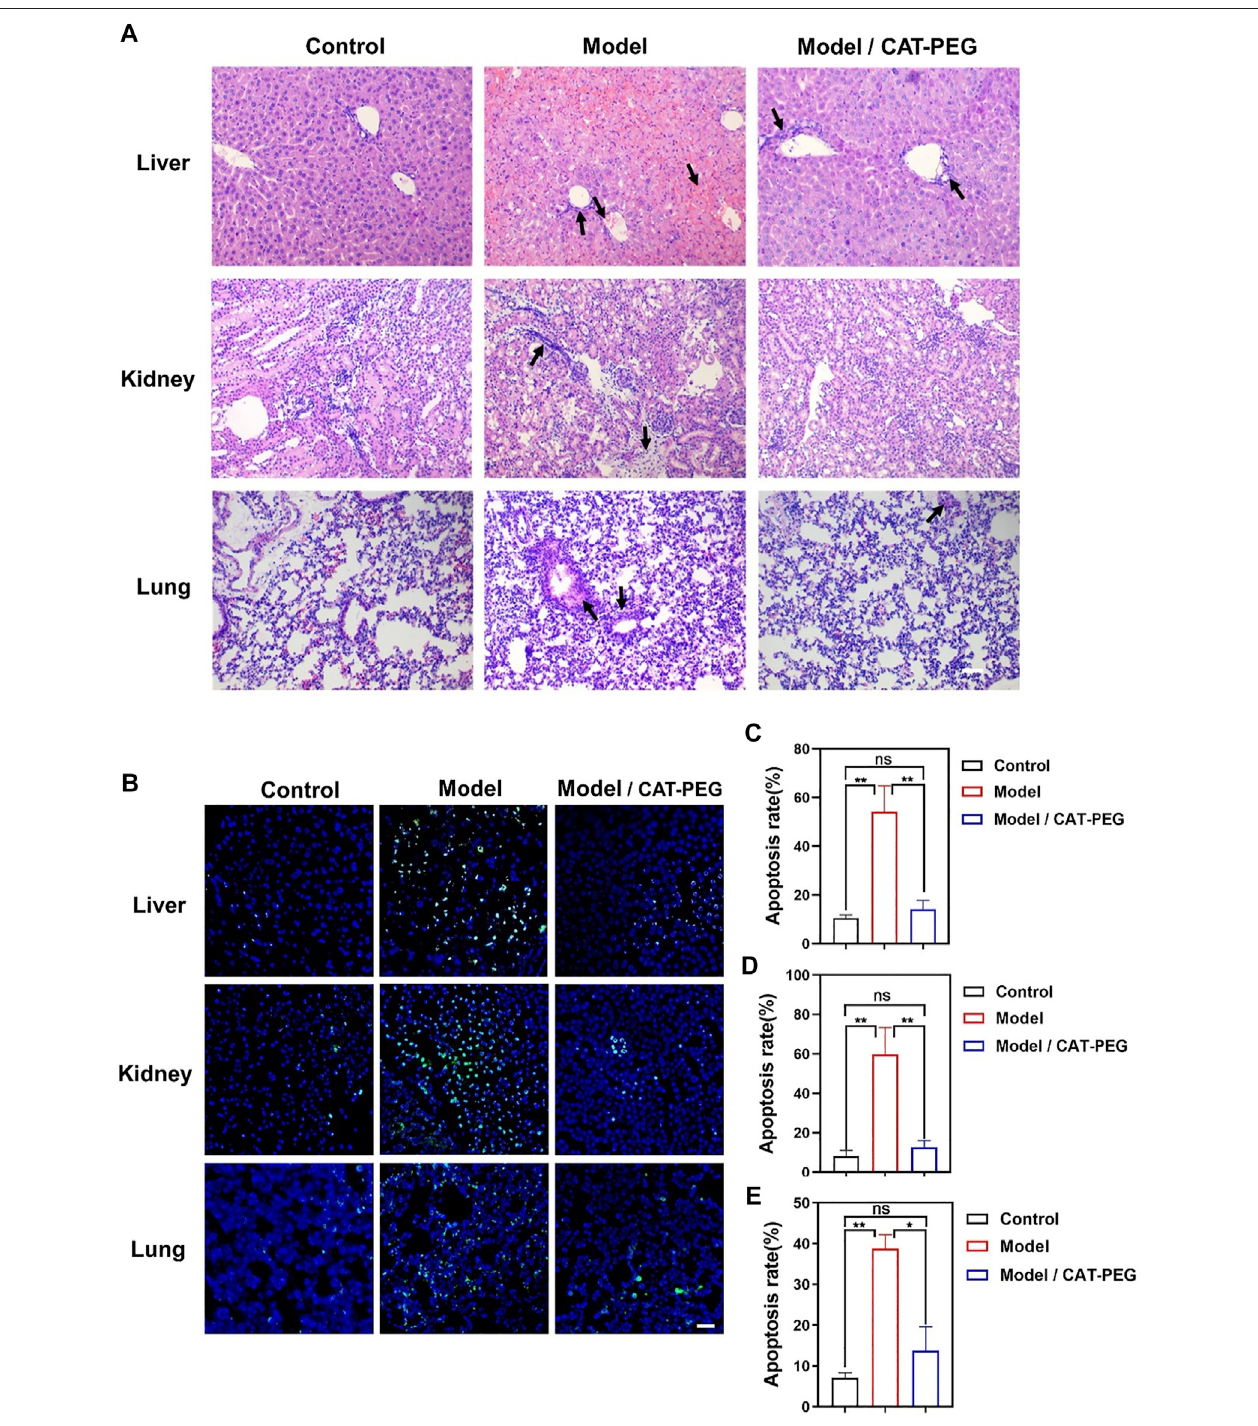
FIGURE5| Histologicanalysisofthecontrol,model,andtreatmentgroup. (A) RepresentativeHand Estainingsectionsofthemajororgans(OriginalMagni fi cation × 200). (B) Terminal deoxynucleotidyl transferase dUTP nick-end labeling (TUNEL) staining of the liver, kidney, and lung sections. Scale bar: 50 μ m. The nucleus was stained with DAPI (blue). Apoptotic cells were stained showing green color. (C – E) The percentage of TUNEL positive cells, which was counted by Leica TCS SP8 Confocallaserscanningmicroscopeforeachsectionandcountedatleastthreeviewing fi eldsineachexperiment.Thetissuefromtopto bottom: liver,kidney,and lung. n (cid:2) 3. Data represent means ± s.e.m. * p ＜ 0.05 and **p ＜ 0.01. ns means not signi fi cant.